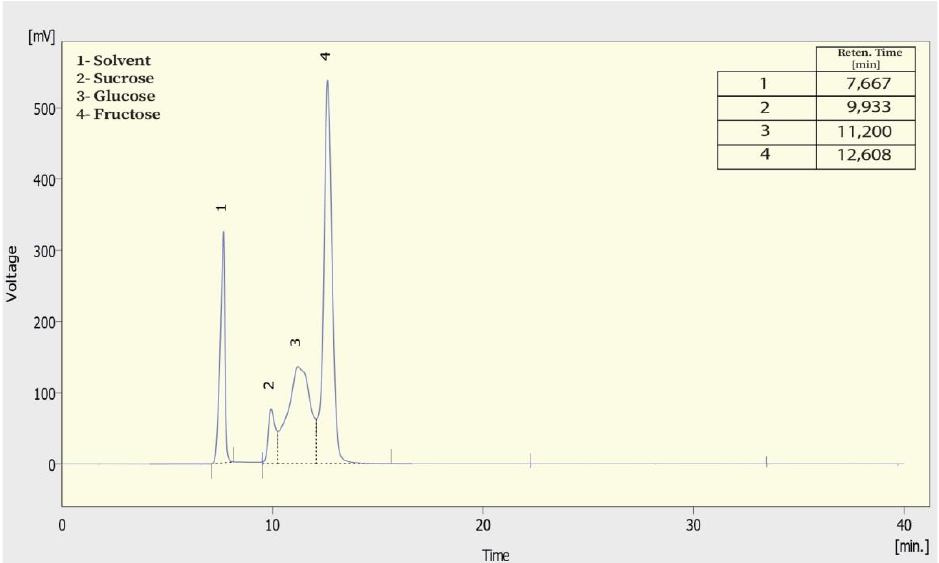
Figure 2. HPLC chromatogram of standards sugar (concentrations of fructose, glucose, and sucrose are 1.957, 3317, and 1.851 g/100 mL, respectively).